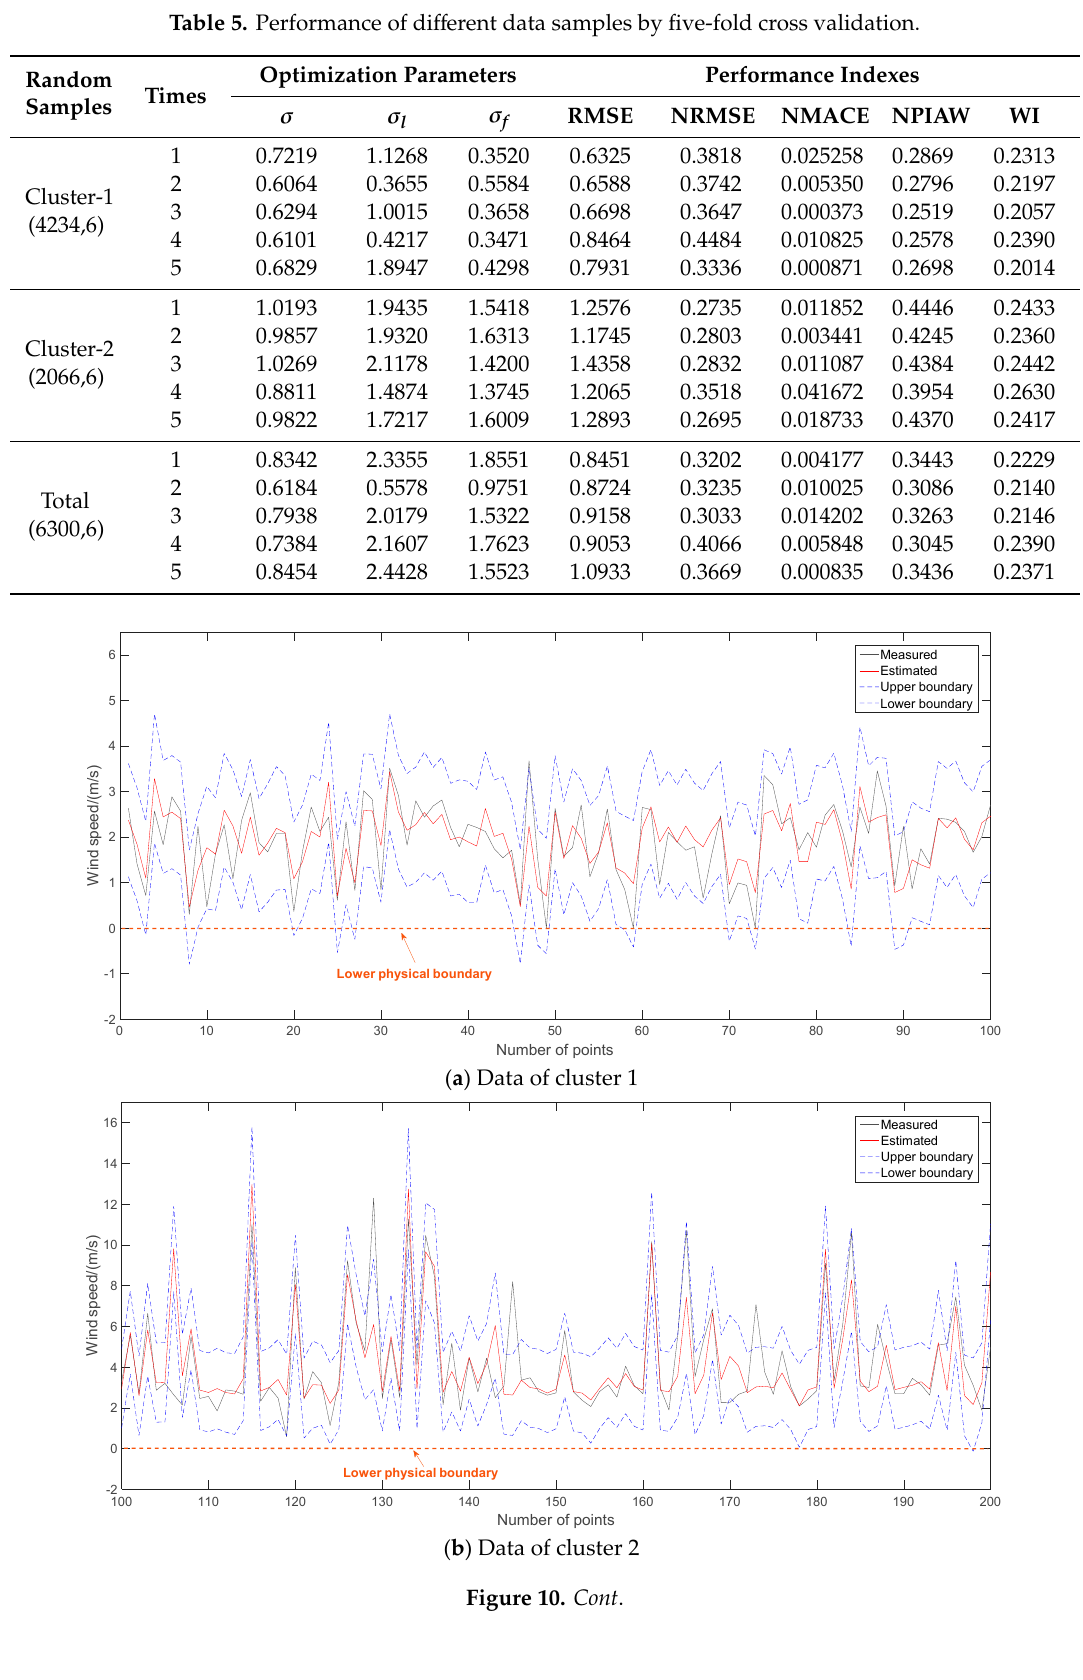
Table 5. Performance of different data samples by five-fold cross validation.